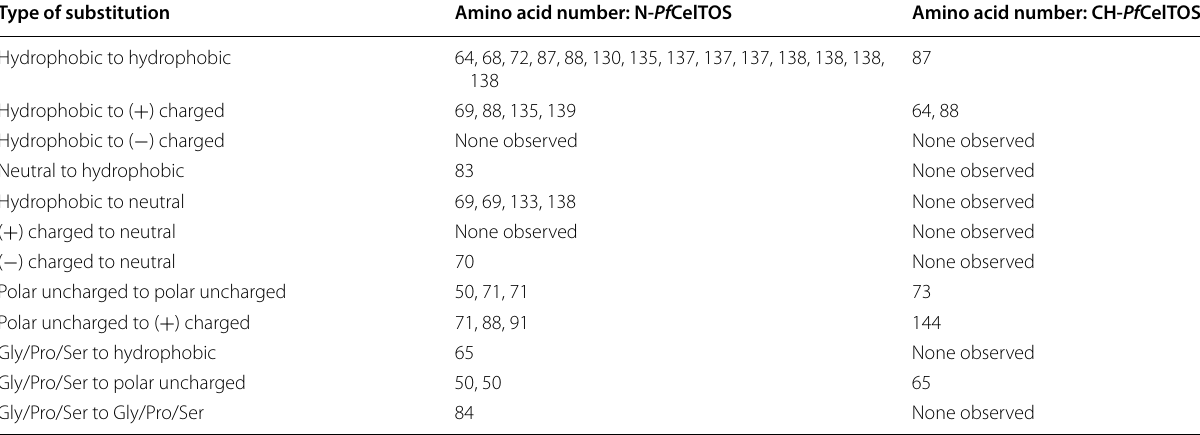
Table 2 Nature of amino-acid substitutions for N- Pf CelTOS and CH- Pf CelTOS Type of